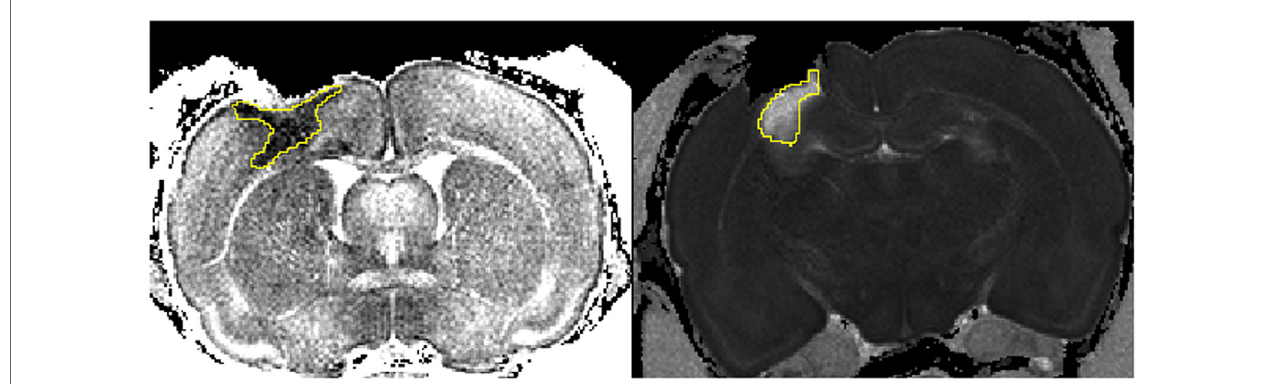
FigUre 1 | cytotoxic and vasogenic edema following injury . Left picture depicts the area of decreased apparent diffusion coefficient (ADC) indicating cytotoxic edema (1 day hypoxic). Right picture shows the area affected by an increase in ADC highlighting vasogenic edema (14 days normoxic). The freehand tool in ImageJ was used to define the areas